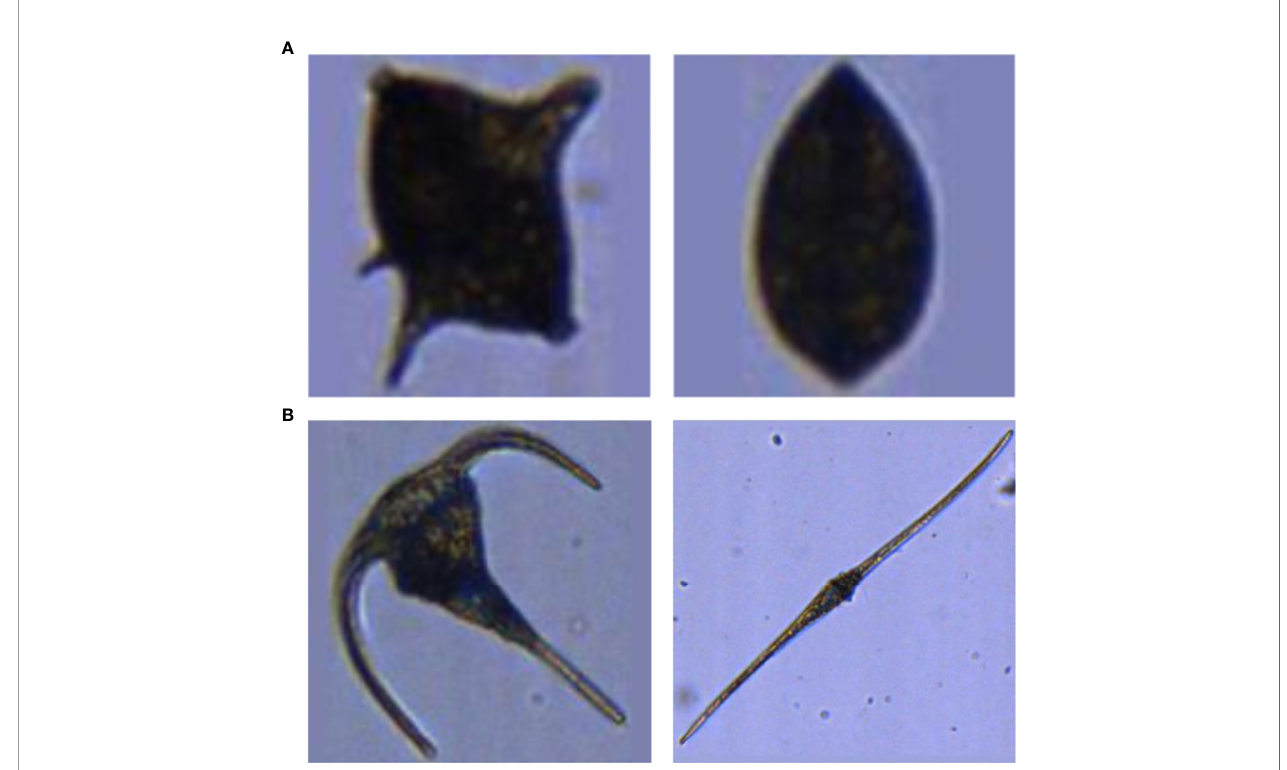
FIGURE 1 | Examples of strong inter-class similarity (A) and high intra-class dissimilarity (B) . (A) A dino fl agellate of the genus Protoperidinium spp. (left), and a juvenile bivalve (right). (B) Two dino fl agellates: Ceratium fusus (left) and Ceratium tripos